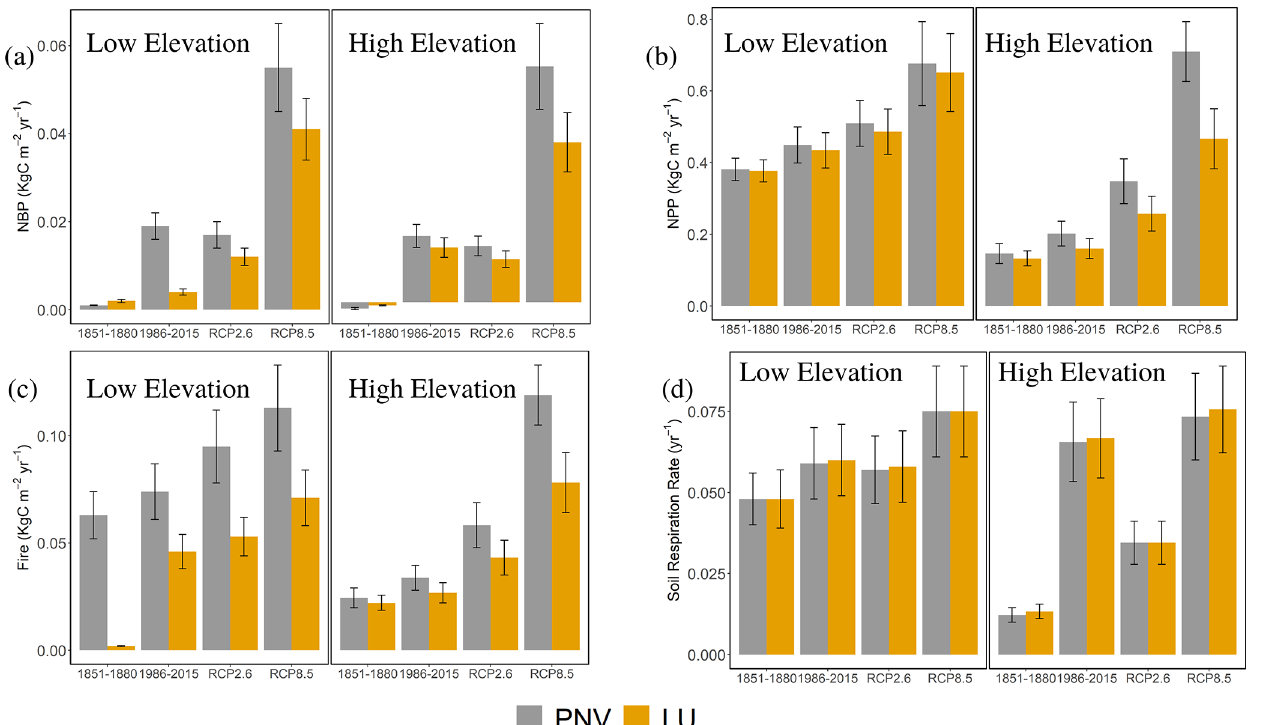
Figure 7. LPJ-GUESS-simulated distribution by CCSM4 on (a) NBP, (b) NPP, (c) fire and (d) soil respiration rate in the HKH according to lower elevation (0–4500m) and higher elevation (greater than 4500m) for PNV (grey colour) and land-use change (orange colour). Vertical black bars illustrate ± standard error, where n =